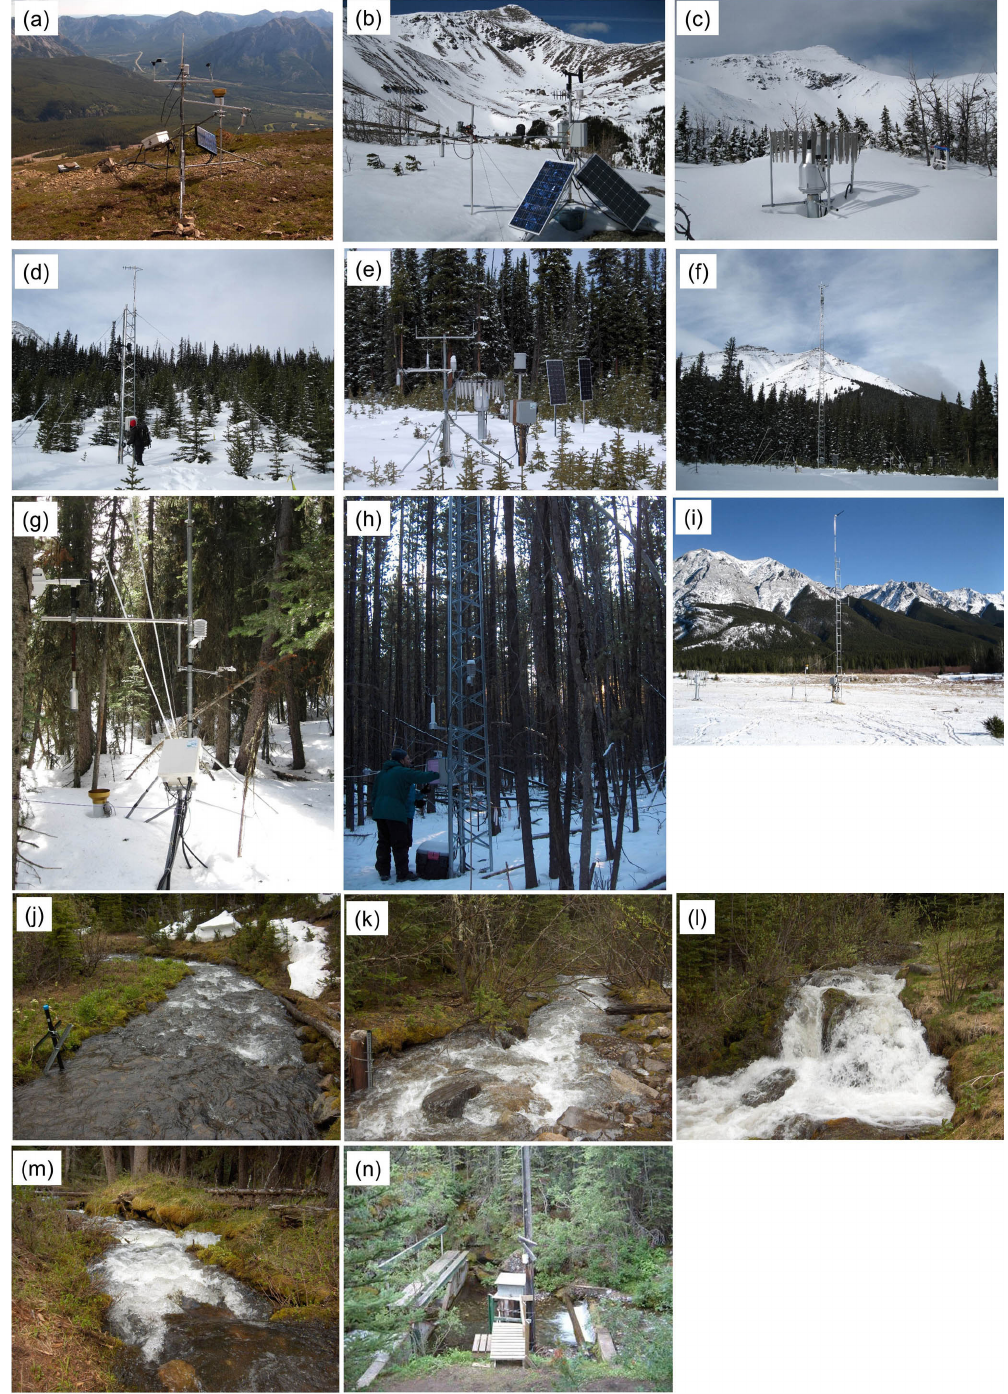
Figure 3. Photos of Marmot Creek Research Basin hydrometeorological and hydrometric stations: (a) Centennial Ridge in July 2010 (2470m), (b) Fisera Ridge tripod station in April 2015 (2325m), (c) Fisera Ridge Geonor gauge in March 2011 (2325m), (d) Vista View in February 2011 (1956m), (e) Upper Clearing tripod station in May 2010 (1845m), (f) Upper Clearing Tower station in February 2011 (1845m), (g) Upper Forest in April 2013 (1848m), (h) Level Forest in January 2010 (1492m), (i) Hay Meadow in February 2012 (1436m), (j) Upper Marmot Creek stream gauge in July 2010 (2200m), (k) Cabin Creek stream gauge in June 2010 (1710m), (l) Middle Creek stream gauge in June 2010 (1754m), (m) Twin Creek stream gauge in June 2010 (1754m), and (n) Marmot Creek stream gauge in June 2010